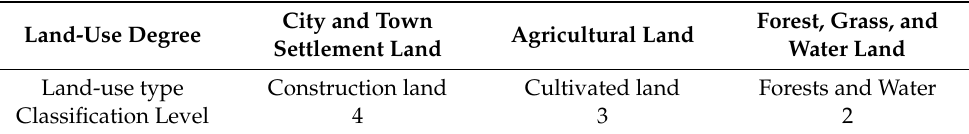
Table 6. Land-use degree.